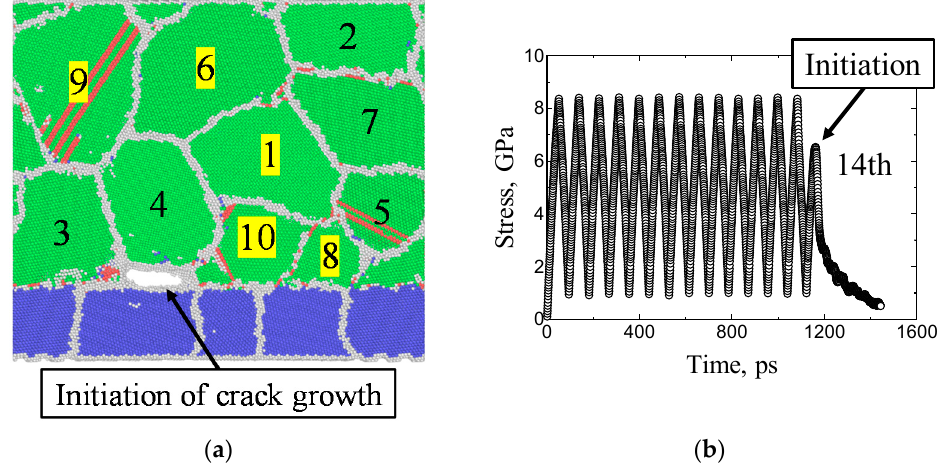
Figure 17. Snapshot at the time of fatigue crack initiation ( a ) and transition of stress during cyclic loading ( b ) when a maximum tensile stress of 8.35 GPa was applied to Model 2.